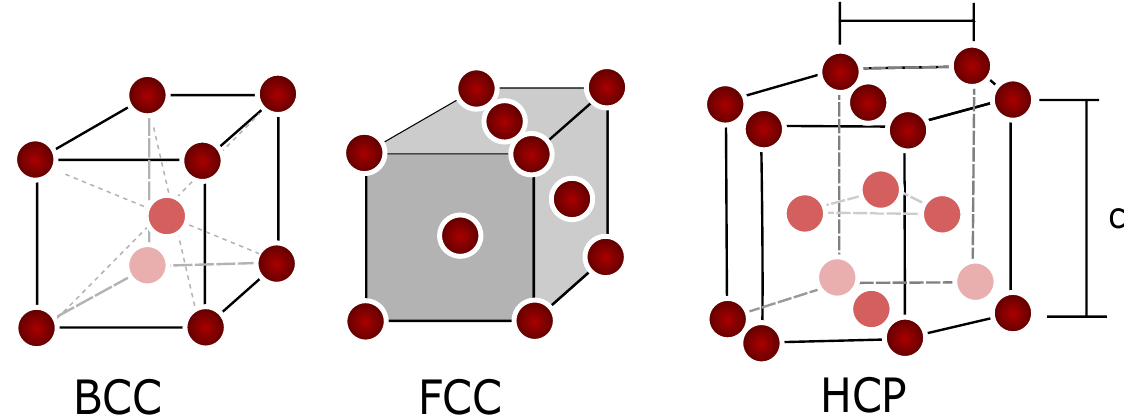
Figure 1. Three typical crystal structures in metals. BCC = Body-Centered Cubic. FCC = Face-Centered Cubic. HCP = Hexagonal Close-Packed. The form ratio for HCP is c / a , ideally c / a = 1.632, but for example, cadmium has c / a = 1.886 and berilium has c / a = 1.586 [23].